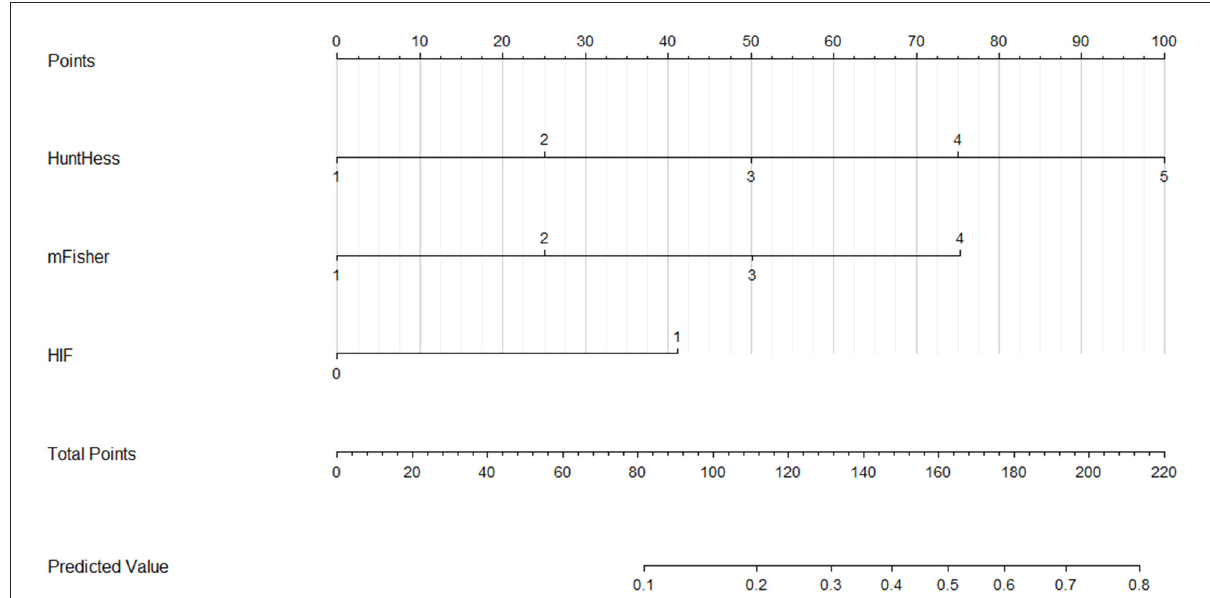
FIGURE5 Nomogram for predicting delayed cerebral ischemia among patients with aneurysmal subarachnoid hemorrhage. Serum hypoxia-inducible factor 1alpha levels combined with Hunt–Hess scores and modified Fisher scores significantly discriminated against patients at risk of delayed cerebral ischemia. For HIF, “1” indicates serum hypoxia-inducible factor 1alpha levels > 229.3 pg/ml and “0” means serum hypoxia-inducible factor 1alpha levels < 229.3 pg/ml. HuntHess, Hunt–Hess scores; mFisher, modified Fisher scores; HIF, hypoxia-inducible factor 1alpha.